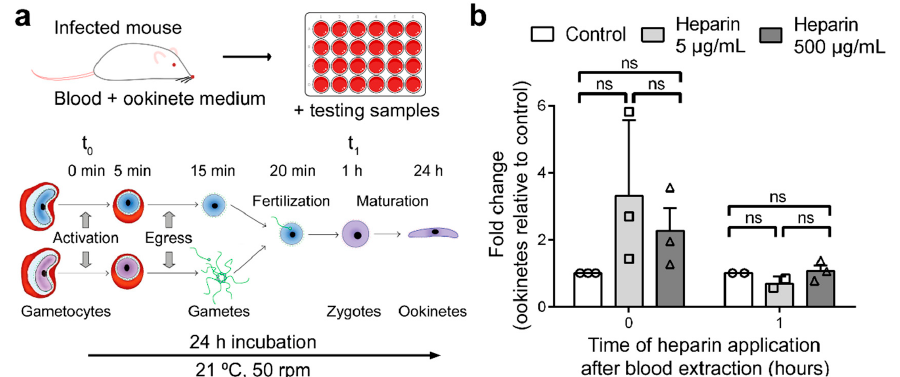
Figure 4. E ff ect of heparin in the ex vivo development of ookinetes. ( a ) Depiction of the method used for the ex vivo growth of ookinetes. The parasite development scheme has been adapted from Kuehn and Pradel [20]. ( b ) E ff ect of heparin on ex vivo ookinete maturation analyzed by flow cytometry (see Figure S4 and Table S1). ns: not